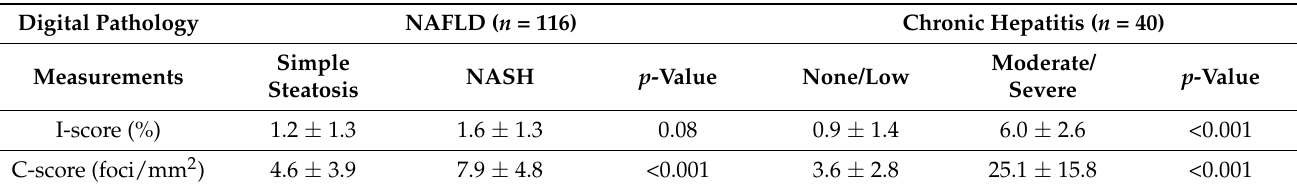
Table 5. Distribution of digital pathology data across disease categories of NAFLD (simple steatosis and NASH) and chronic hepatitis (none/low and moderate/severe